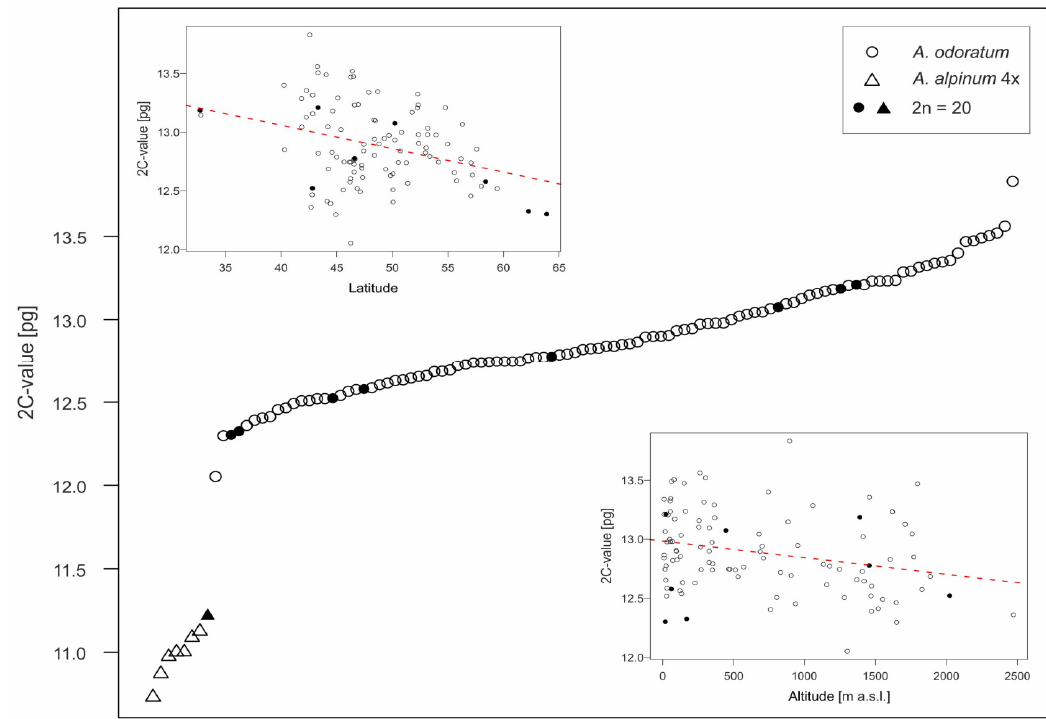
Figure 2. Absolute genome size variation of two tetraploid species studied, A. odoratum (open circles) and A. alpinum (open triangles). Closed symbols indicate individuals with a counted number of chromosomes. Two insets show the correlation of A. odoratum genome size with latitude (top left) and altitude (bottom right).